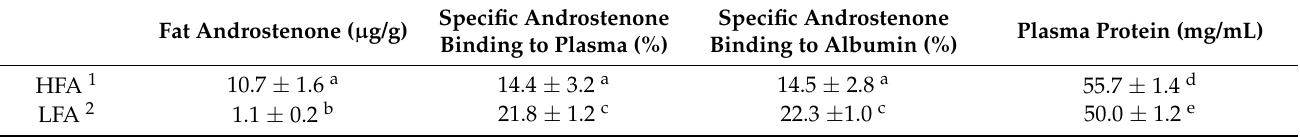
Table 2. The specific binding of androstenone to plasma proteins and albumin and corresponding fat androstenone and plasma albumin concentrations. Fat Androstenone ( µ